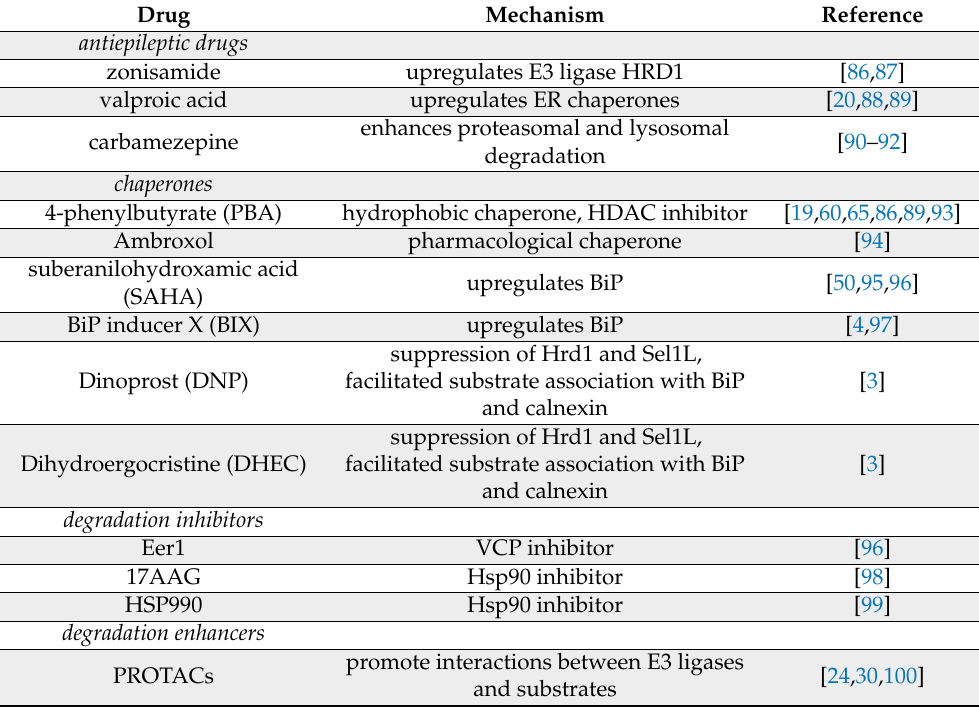
Table 2. Drugs with effects on proteostasis and with potential use for